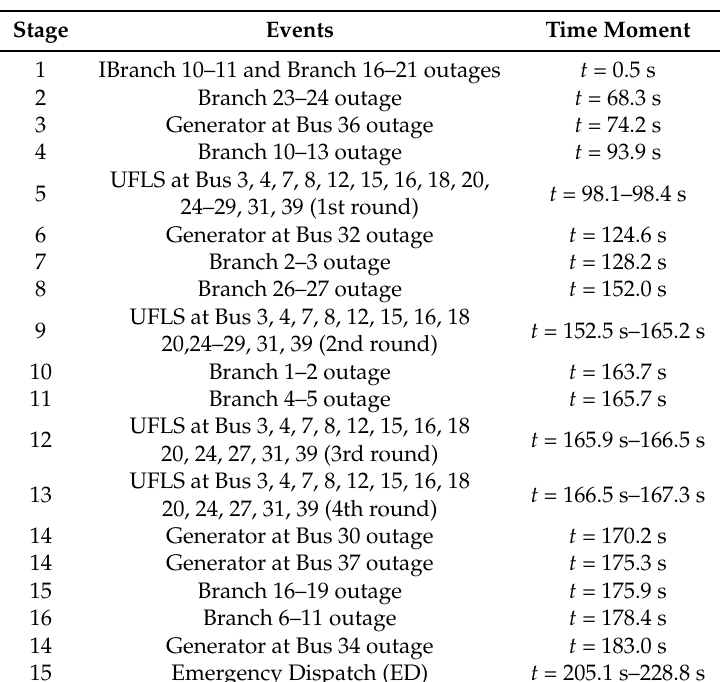
Table 3. Event list of cascading